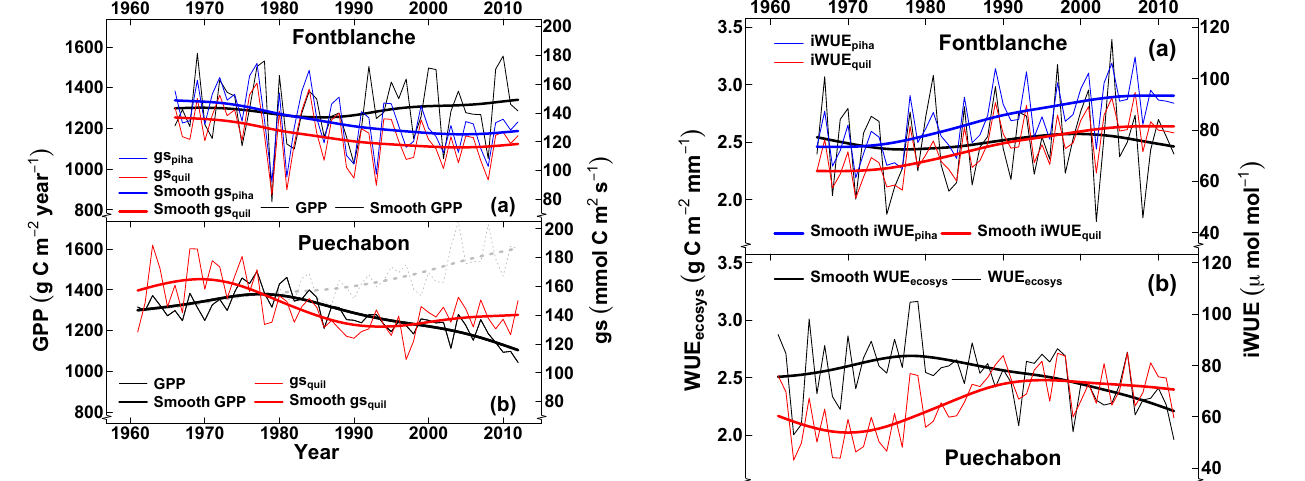
Figure 6. Modelled total annual stand gross primary productivity (GPP) and mean stomatal conductance of sun leaves (gs) for Font- blanche (a) and Puechabon (b) for the period for which meteorolog- ical data were available. To show the influence of the precipitation decline observed in Puechabon on GPP, we run a sensitivity simula- tion in which precipitation was fixed for 1980–2012 on the basis of precipitation in 1960–1979 (Fig. A1) and all other input variables ( T min , T max , [CO 2 ]) were actual values. GPP values from this sim- ulation are depicted as dashed grey lines in (b) .